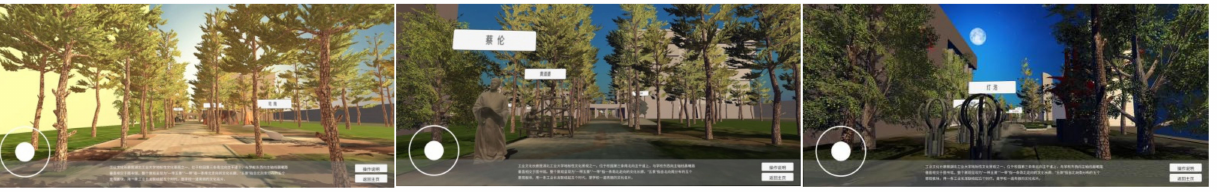
Figure 12. Presentation of the different environments of the virtual